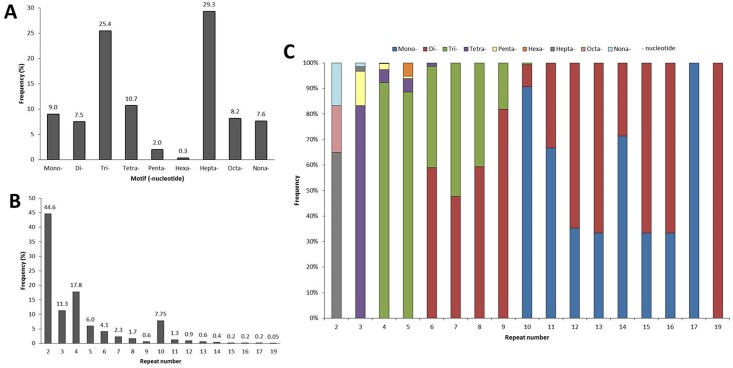
Frequency of 1899 EST-SSRs with different motifs and repeat number.A. Frequency of EST-SSRs with mono-, di-, tri-, tetra-, penta-, hexa-, hepta-, octa- and nonanucleotide motifs. B. Frequency of EST-SSRs with 2 to 19 repeat motifs. C. Frequency of mono-, di-, tri-, tetra-, penta-, hexa-, hepta-, octa- e nonanucleotide motifs for each repeat number category.